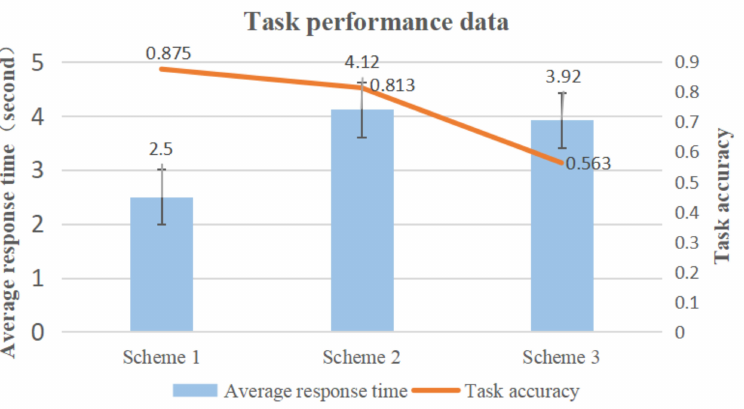
Figure 10. Average reaction time and correct rate results.